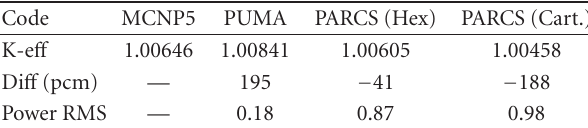
Table 5: CNA-I idealized core—unrodded.